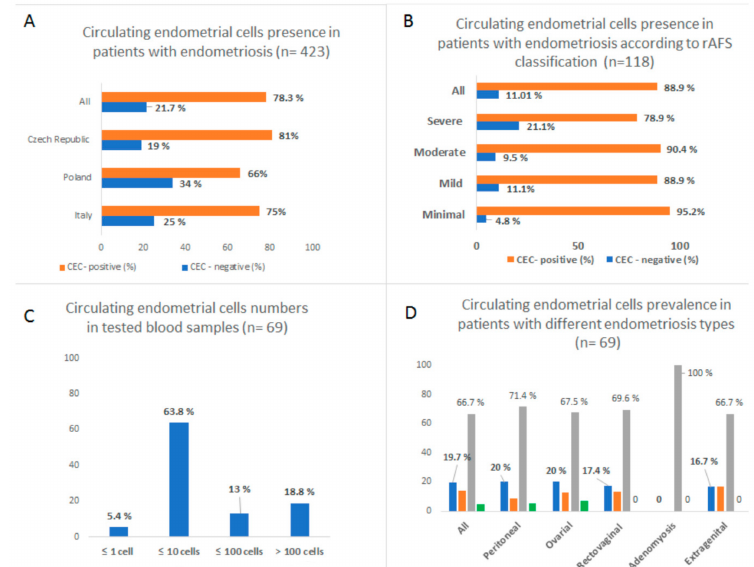
Figure 1. Circulating endometrial cells (CECs) presence in patients with endometriosis. ( A ) CEC- positive / negative sample frequency is shown for all of the tested patients. ( B ) CEC-positive / negative sample frequency is shown in connection to the revised American Fertility Society (rAFS)